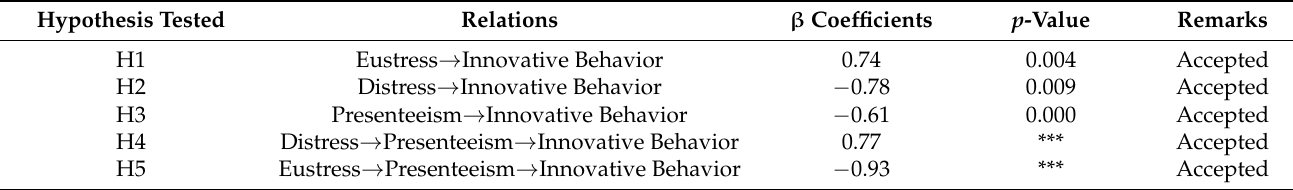
Table 6. Hypotheses testing.